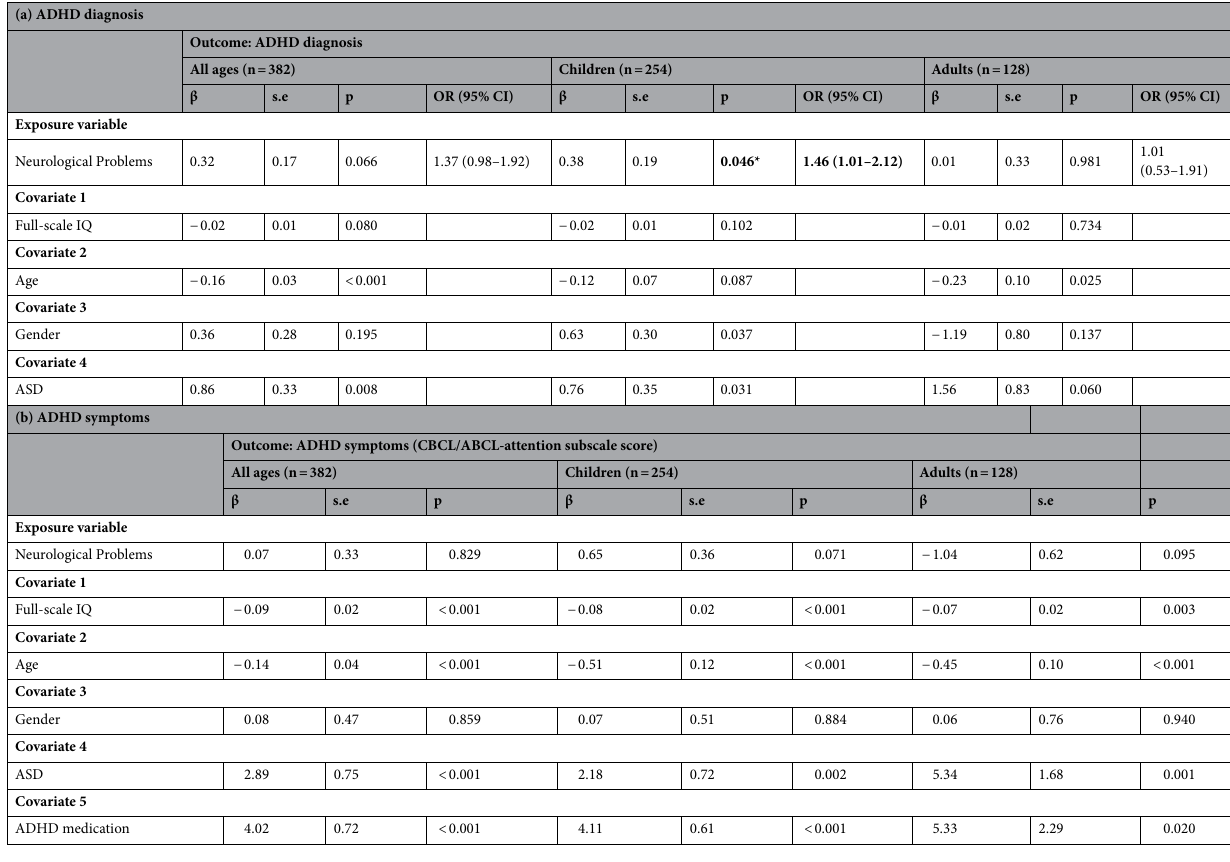
Table 3. Associations between neurological problems and ADHD in the total sample. Bold values indicates statistical significance *p < 0.05. ADHD attention-deficit/hyperactivity disorder, ASD autism spectrum disorder, CBCL the Child Behavior Checklist, ABCL Adult Behaviour